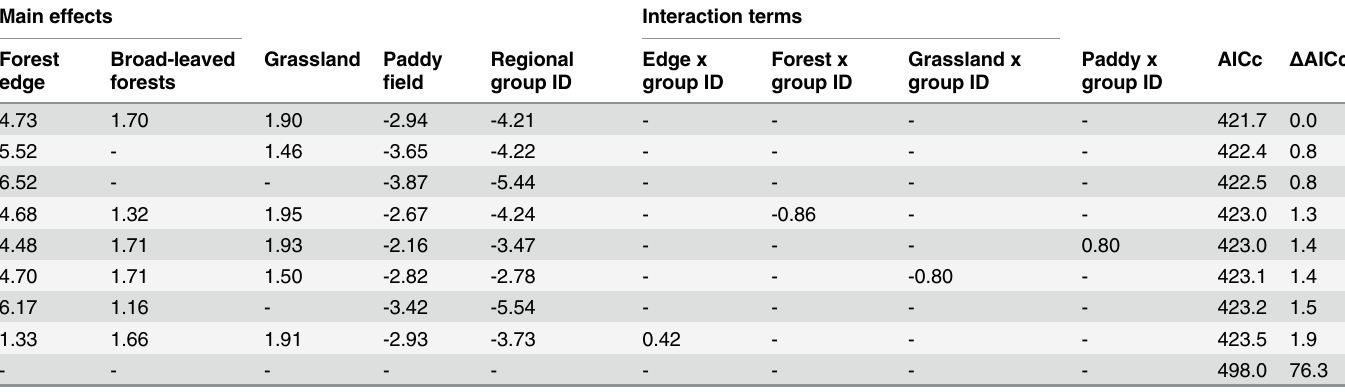
Table 3. Selected models for 2 regional groups based on prey-item similarity (southern and others) to explain relationships between buzzard occurrence and landscape